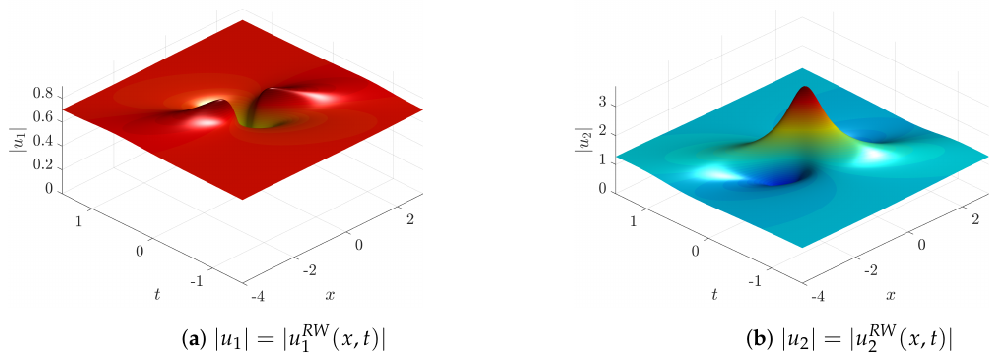
Figure 7. RW solutions corresponding to the spectrum 1 G 1 B 0 L . q = 1, s 1 = 1, s 2 = − 1 (mix), r = 2, p = − 1 ( a 1 = 0.70711, a 2 = 1.2247); λ c = 0.58994 + 1.1698 i , c = c 2 = 0, c 1 = 1,